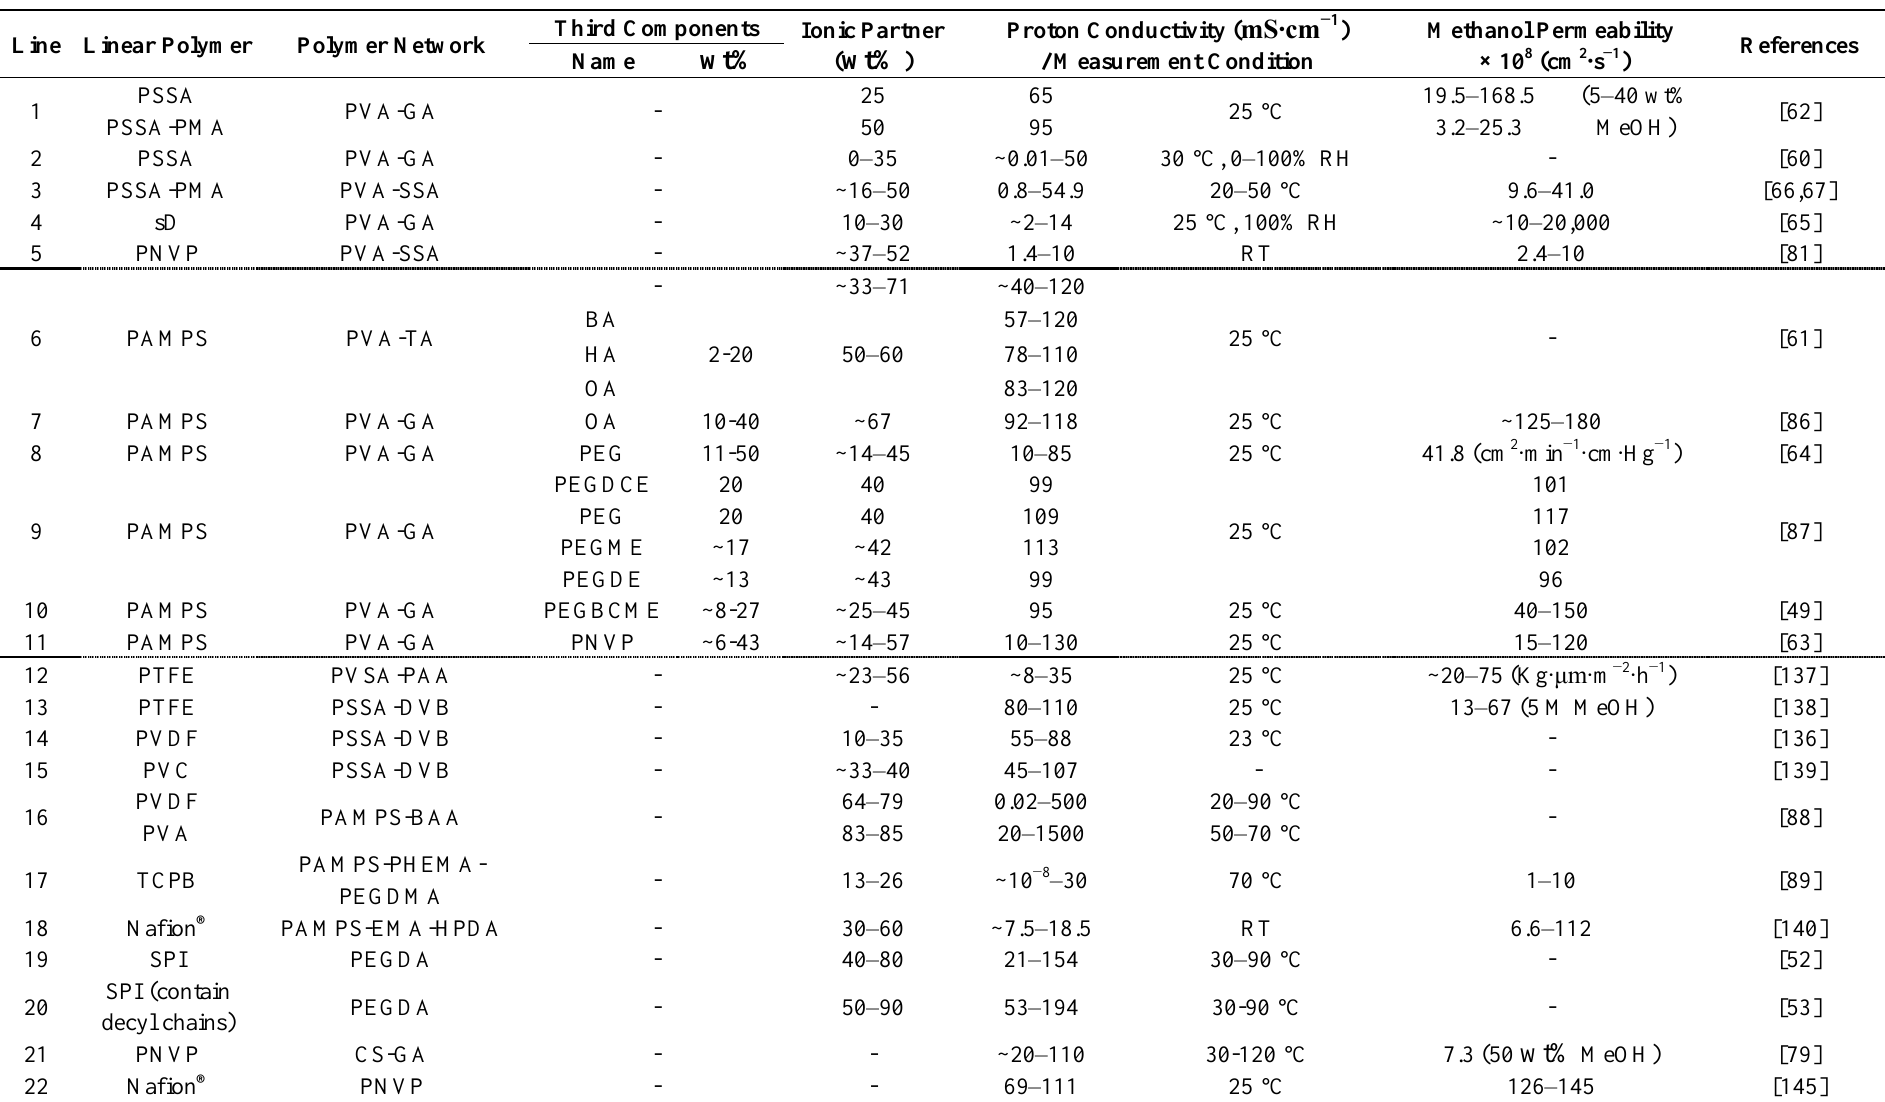
Table 5. Characteristic of various semi-IPN membranes involve water soluble polymers. Line Linear